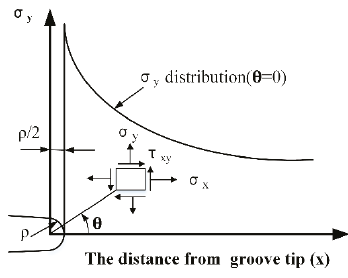
Figure 4. The stress state of the incision ′ s root.